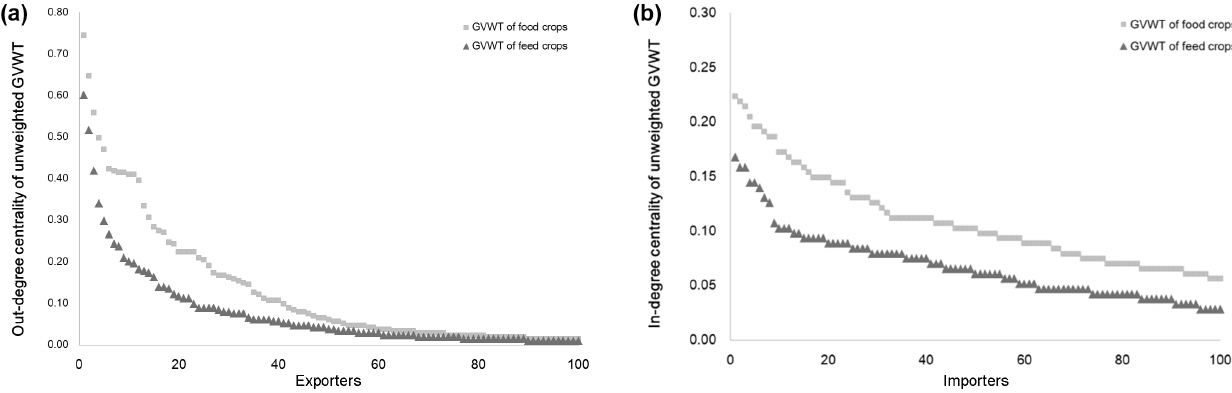
Figure 3. Out- and in-degree centrality in connection network of GVWT for food and feed crops during the period 2006–2010. (a) Out-degree centrality and (b) in-degree